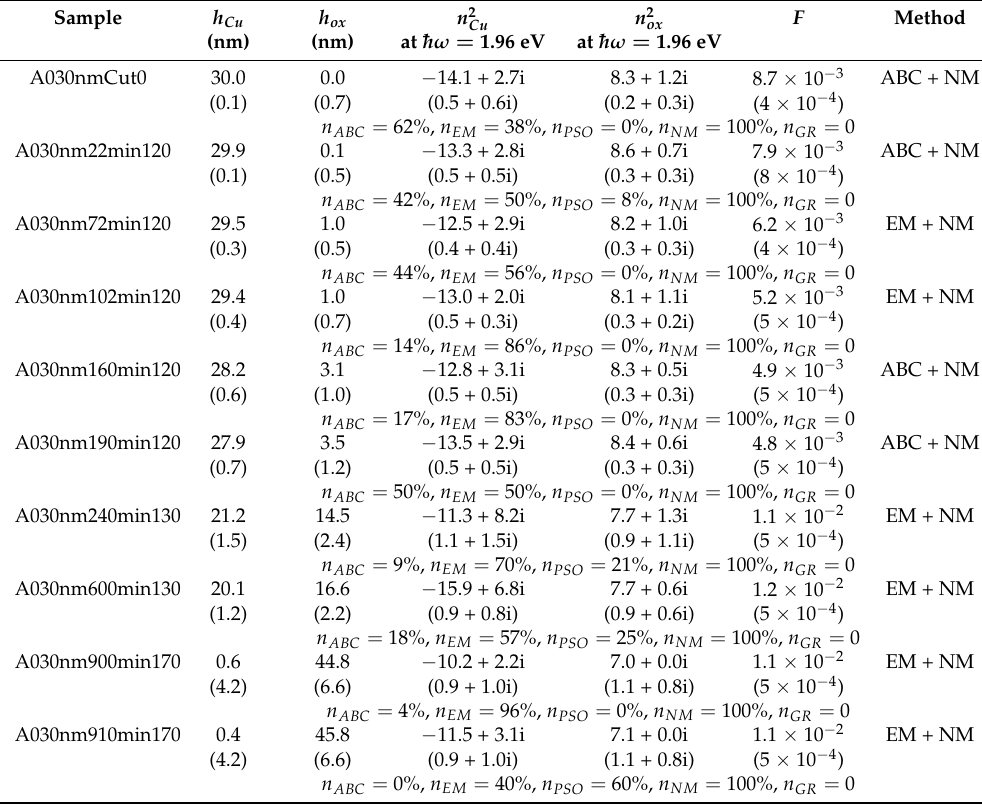
Table A4. The recovered thickness of copper and Cooper oxide, the relative permittivity of copper and copper oxide at λ 0 = 632.8 nm, by fitting experimental UV-visible-NIR absorbance curves. The recovered relative permittivities can be compared to those of bulk copper and copper oxide, resp. − 11.55 + 1.57i and 8.64 + 0.64i [29]. The value of the multi-objective function F (Equation (A3)) and the most efficient metaheuristics are also indicated. Values between brackets are standard deviation for acceptable solutions, i.e., obtained for F below the 25% threshold (for F ∈ [ min ( F ) ;1.25 × min ( F )] . The corresponding success of each metaheuristic is indicated in